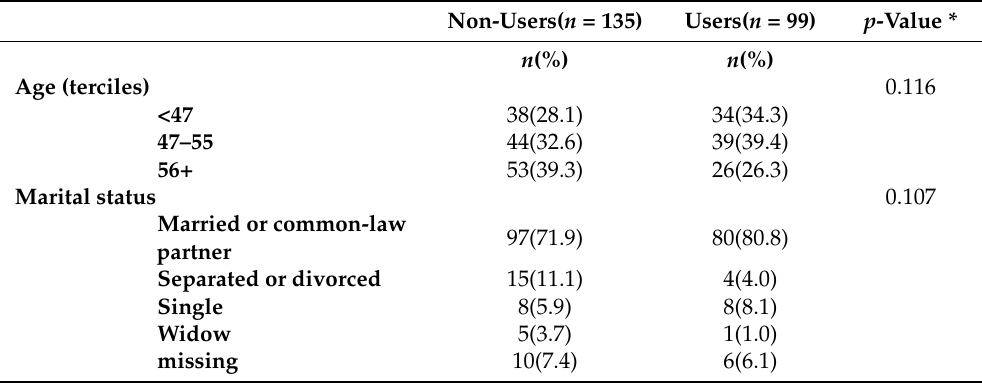
Table 1. Description of